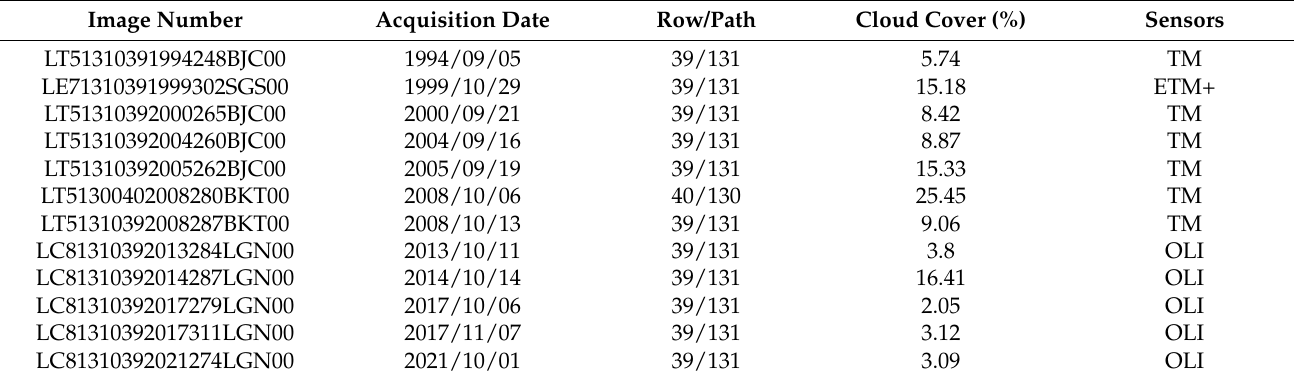
Table 2. Detailed information on Landsat images used in this